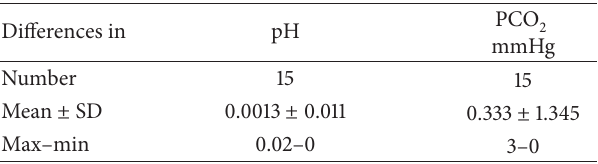
Table4:Differencesofbloodgasparametersmeasuredinthesimul- taneously sampled arterial blood and of the arterialized capillary blood in COPD patient with various